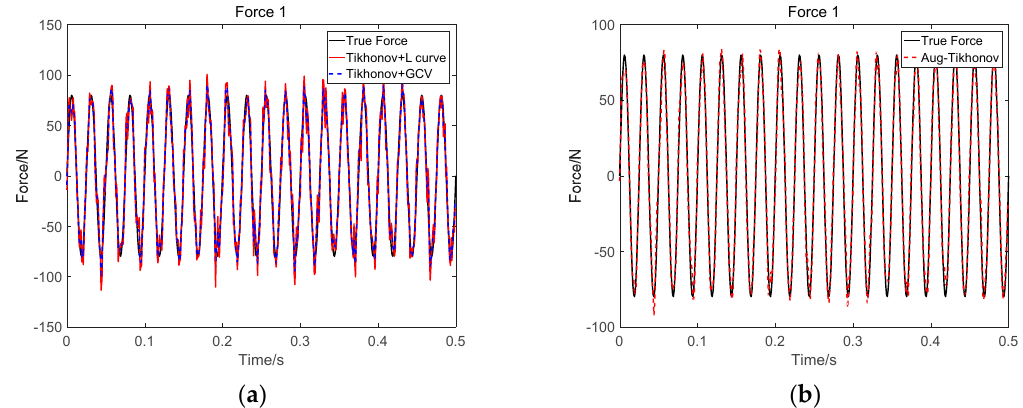
Figure 14. Identification result of two sinusoidal loads at SNR 40 dB (Force 1): ( a ) Tikhonov method; ( b ) the proposed method.